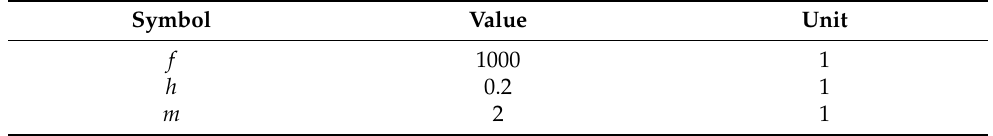
Table 4. Parameters of the empirical viscosity modification due to